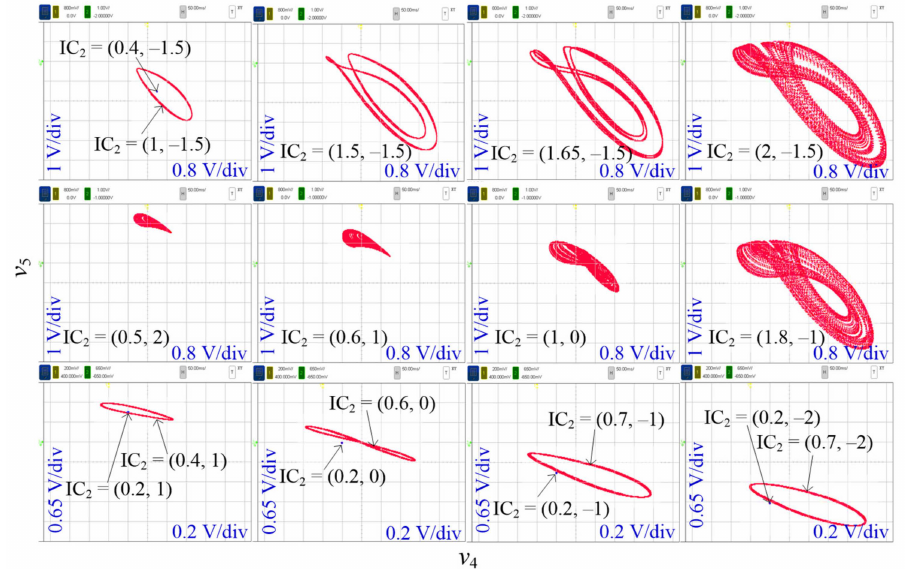
Figure 12. Experimentally acquired phase portraits of the memristor initial condition-induced attractors in the plane of v 4 and v 5 with fixed IC 1 = ( v 1 (0), v 2 (0), v 3 (0)) = (1 nV, 0 V, 0 V), and varied IC 2 = ( v 4 (0), v 5 (0))(unit: